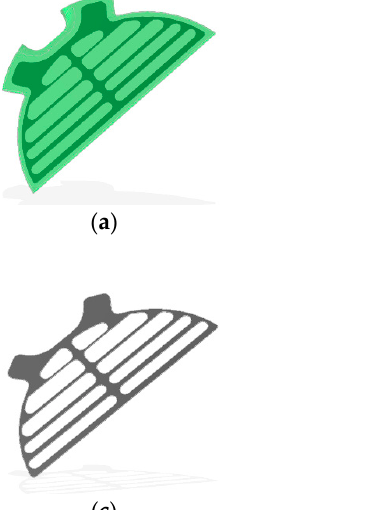
Figure 4. Outflow valve construction details: ( a ) composite leaflet, ( b ) polyurethane valve ring, ( c ) open-shape frame, ( d ) the metal frame.